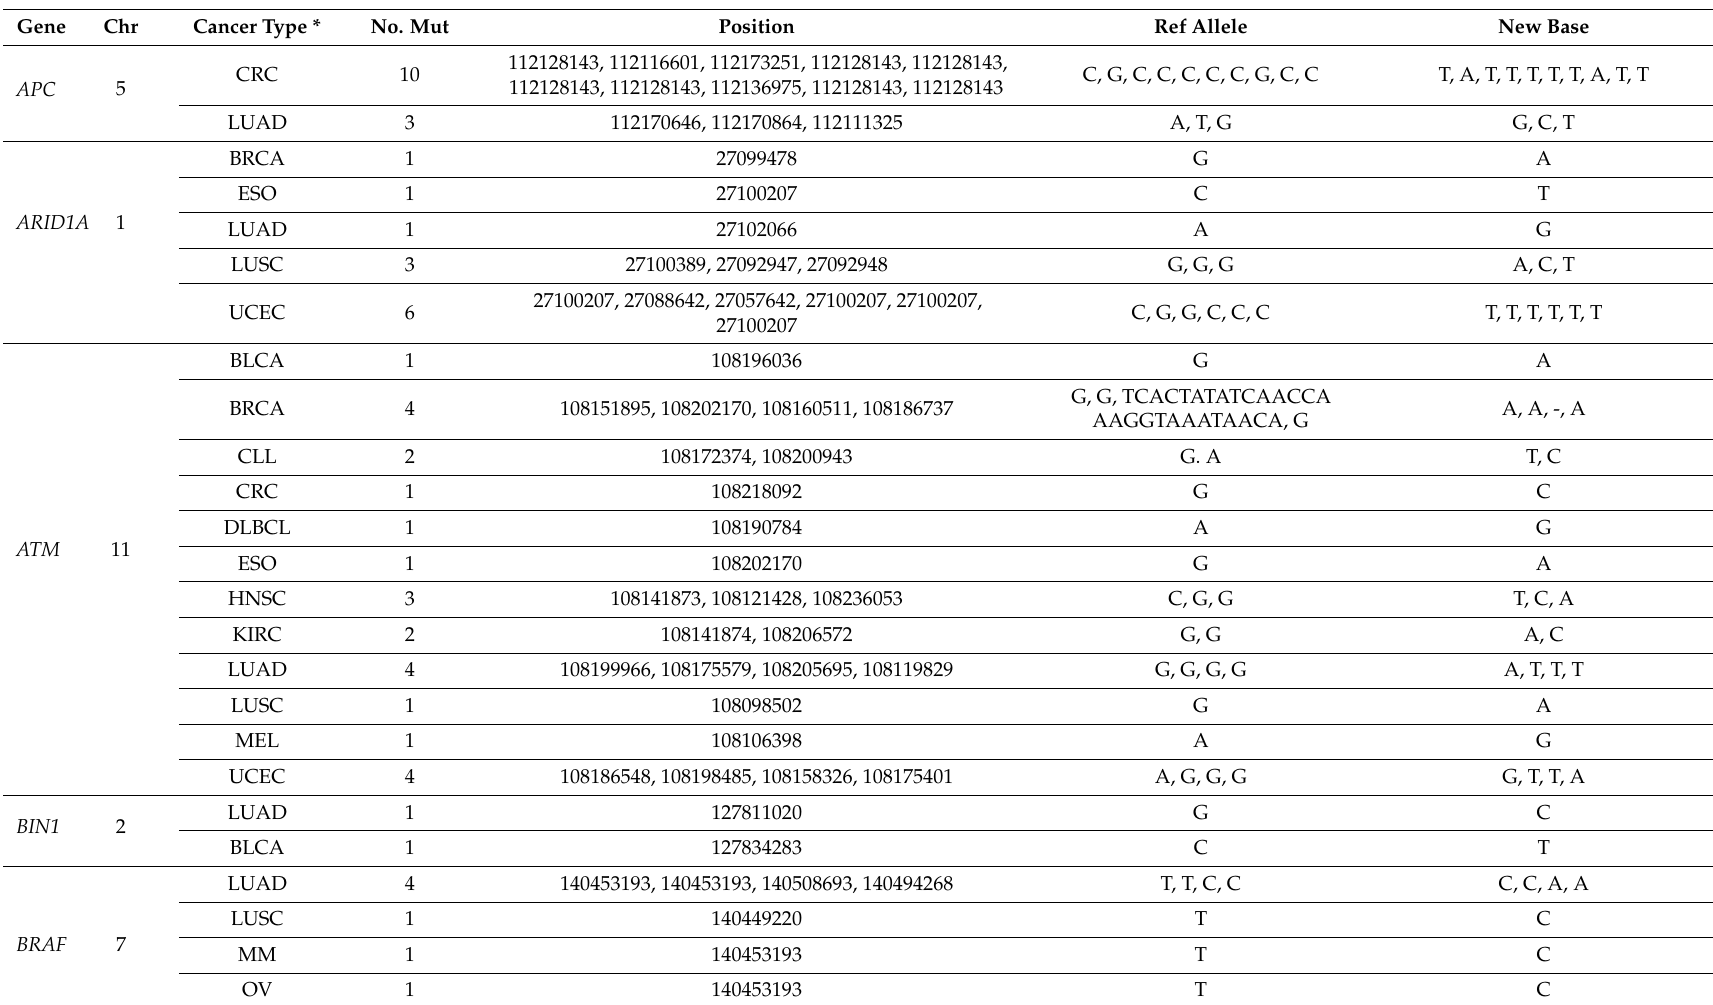
Table 2. Alternative splicing-associated mutations in cancer-related